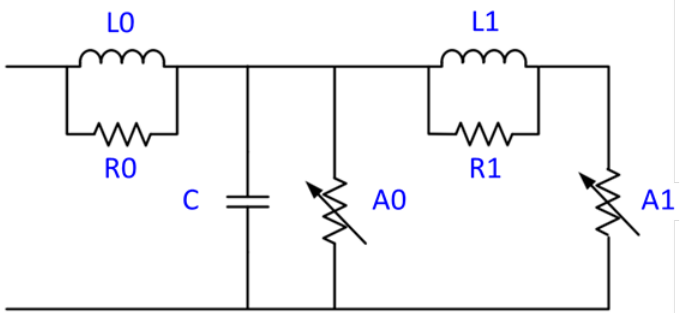
Figure 3. Institute of Electrical and Electronics Engineers’ (IEEE) frequency-dependent model surge arrester.